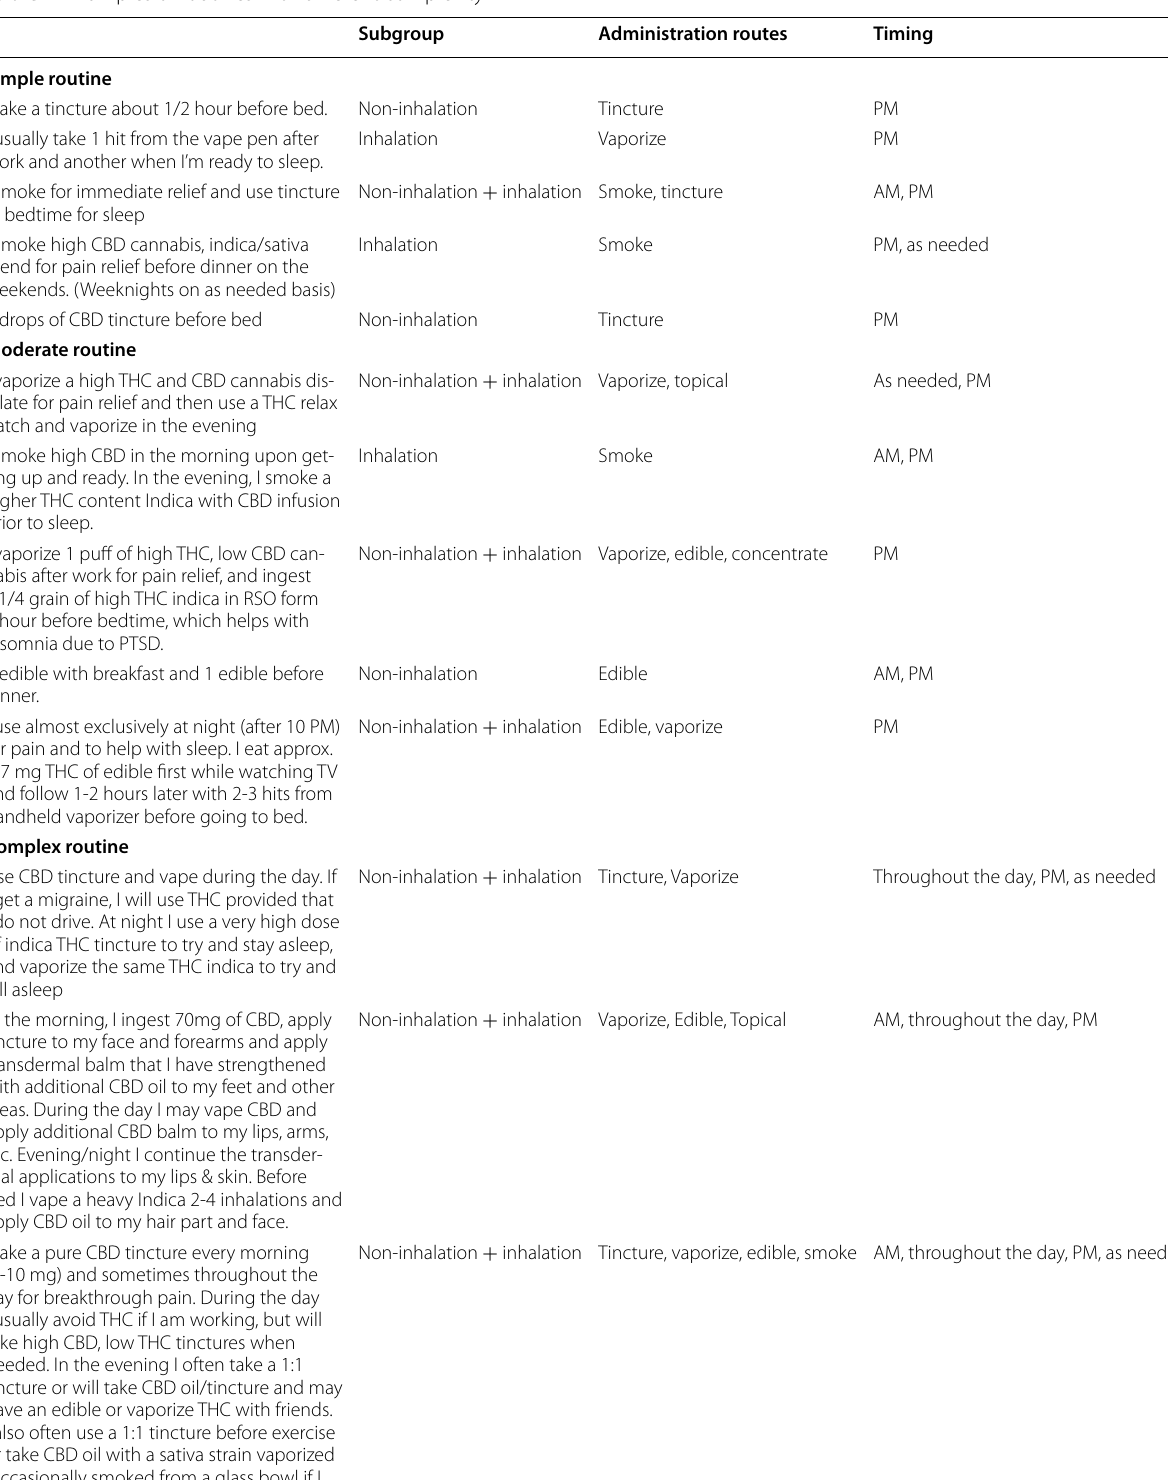
Table 2 Examples of routines with different complexity Subgroup Administration routes